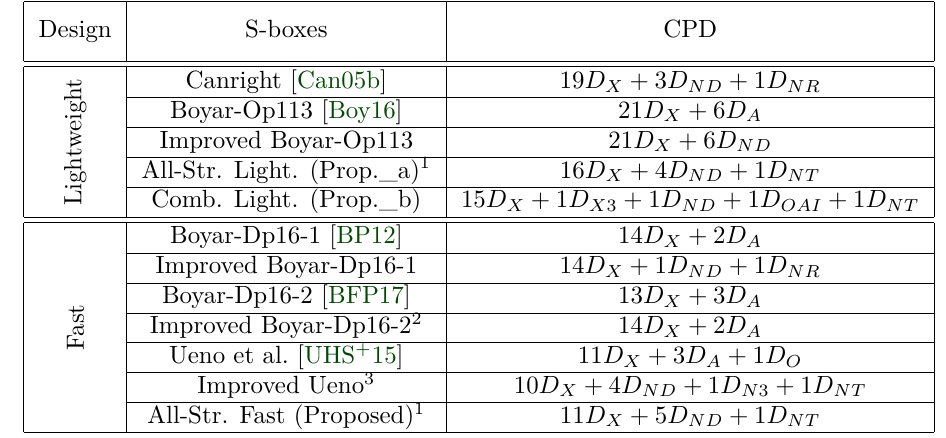
Table 11: Time complexity comparison of different S-boxes (X=XOR2/XNOR2, X3=XOR3, A=AND2, O=OR2, ND=NAND2, N3=NAND3, OAI=OAI32, NR=NOR2,